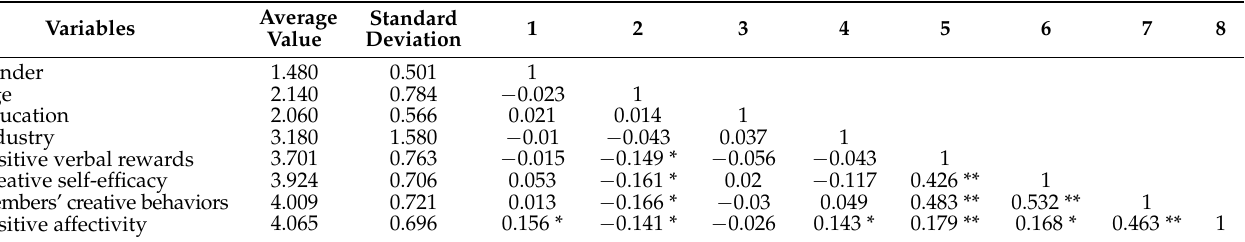
Table 3. Correlation